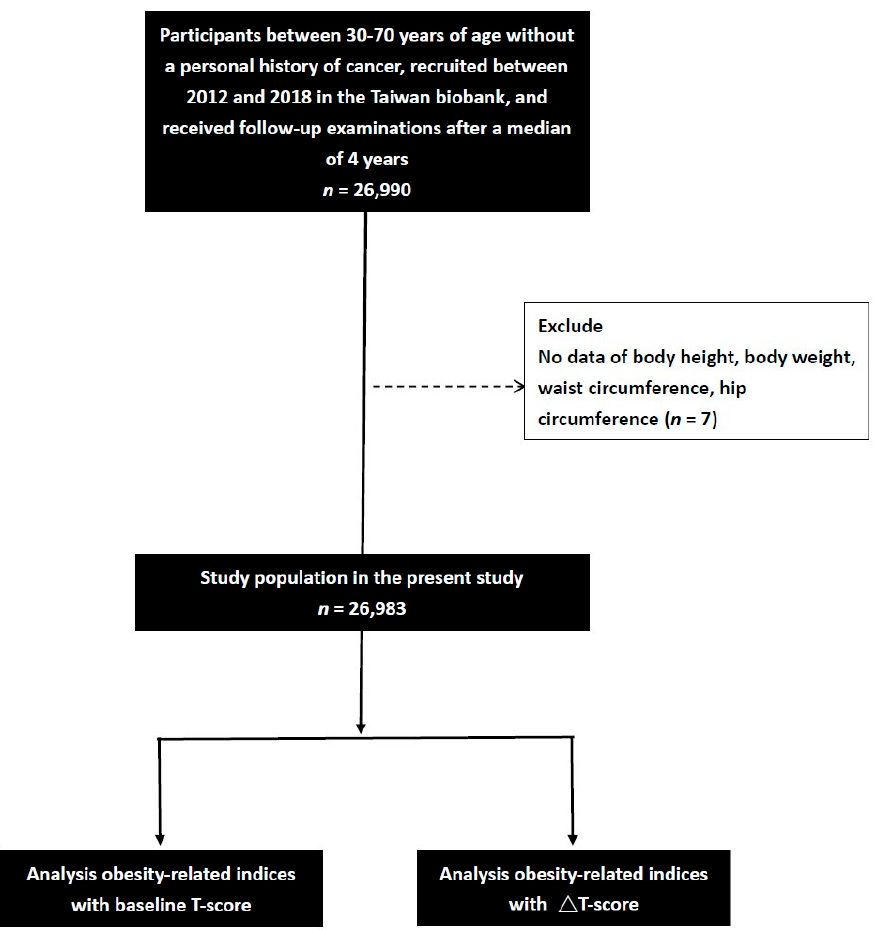
Figure 1. Flowchart of study population. The change in T-score ( ∆ T-score) was calculated as the T-score at follow-up minus that at baseline.